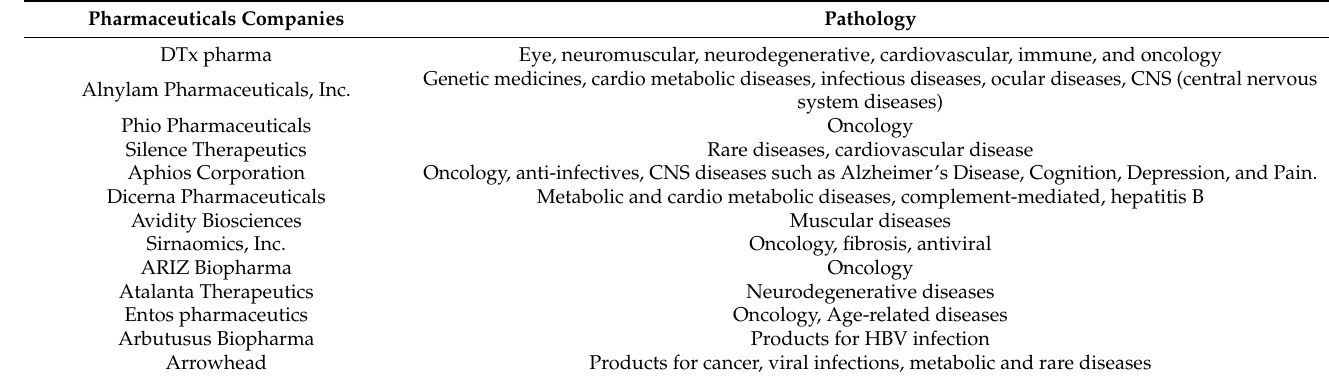
Table 2. Biopharmaceutical companies involved in siRNA therapeutics